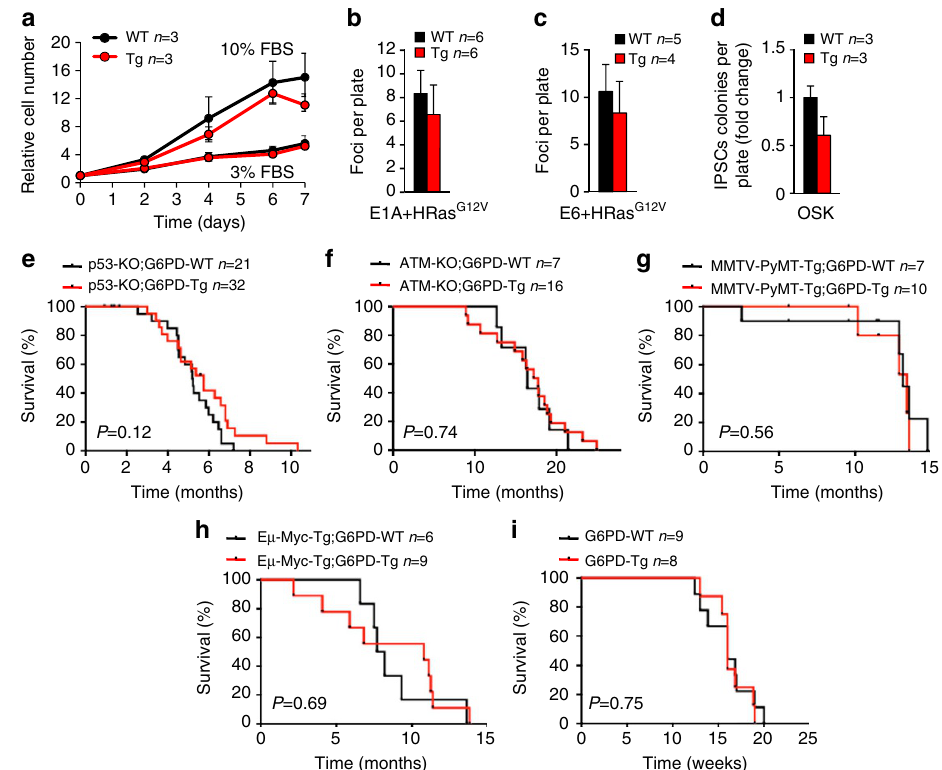
Figure 3 | Cancer susceptibility is not affected in G6PD-Tg mice. ( a ) Growth curves of primary MEFs at the indicated serum concentrations. ( b , c ) Number of neoplastic foci in MEFs transduced with E1a/HRas GV12 ( b ) or with E6/HRas G12V ( c ) after 2 weeks. ( d ) Fold change of reprogramming efficiency of primary MEFs after transduction with Oct4 , Sox2 and Klf4 . ( e – i ) Survival curves of the indicated mouse lines and experiments. ( e ) p53- KO;G6PD-WT, n ¼ 21, 7 females (F); 14 males (M). p53-KO;G6PD-Tg, n ¼ 32, 12F, 20M. ( f ) ATM-KO;G6PD-WT, n ¼ 7, 3F, 4M; ATM-KO;G6PD-Tg, n ¼ 16, 6F, 10M. ( g ) MMTV-PyMT-Tg;G6PD-WT, n ¼ 7F; MMTV-PyMT-Tg;G6PD-Tg, n ¼ 10F. ( h ) E m -Myc-Tg;G6PD-WT, n ¼ 6, 3F, 3M; E m -Myc-Tg;G6PD-Tg, n ¼ 9, 4F, 5M. ( i ) Survival curve of mice injected intramuscularly with 3MC, G6PD-WT n ¼ 9, 1F, 8M; G6PD-Tg n ¼ 8M. Bars represent mean ± s.e.m.